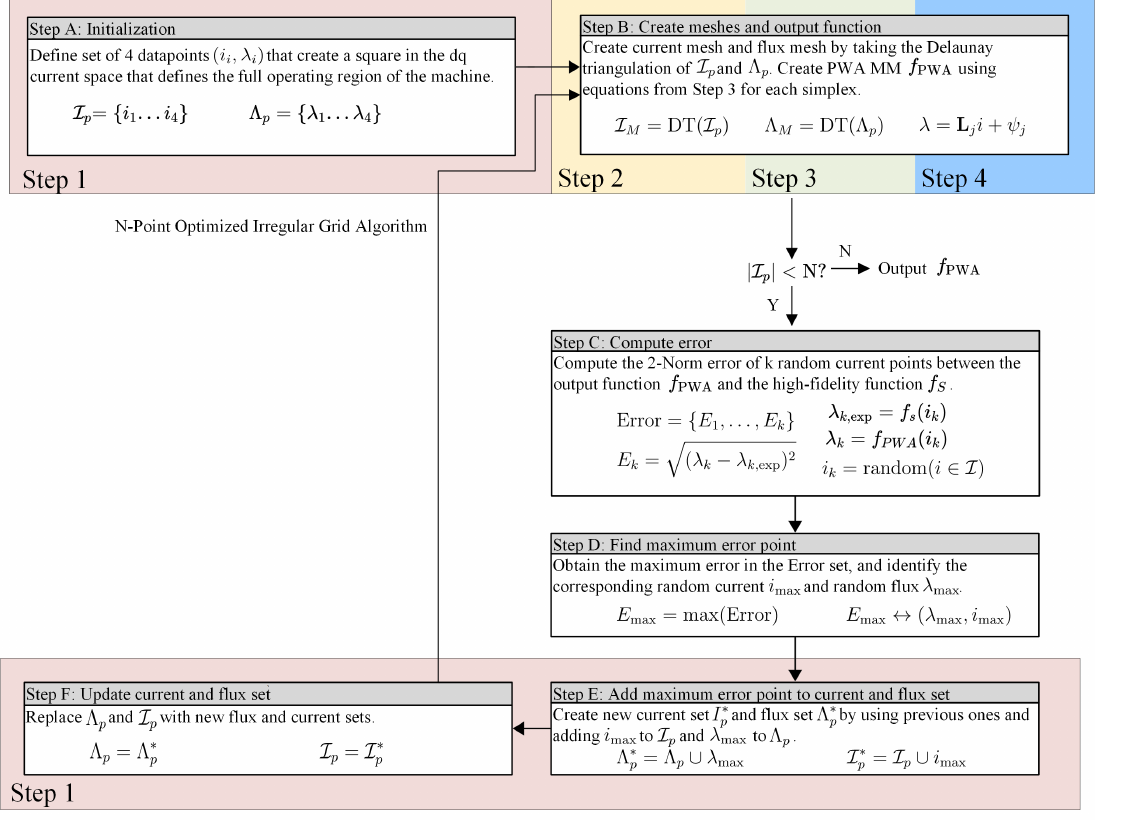
Figure 9. PWA MM optimization algorithm to minimize the maximum two-norm flux error in f PWA given an allotted N number of of points to use ( |I P | = N